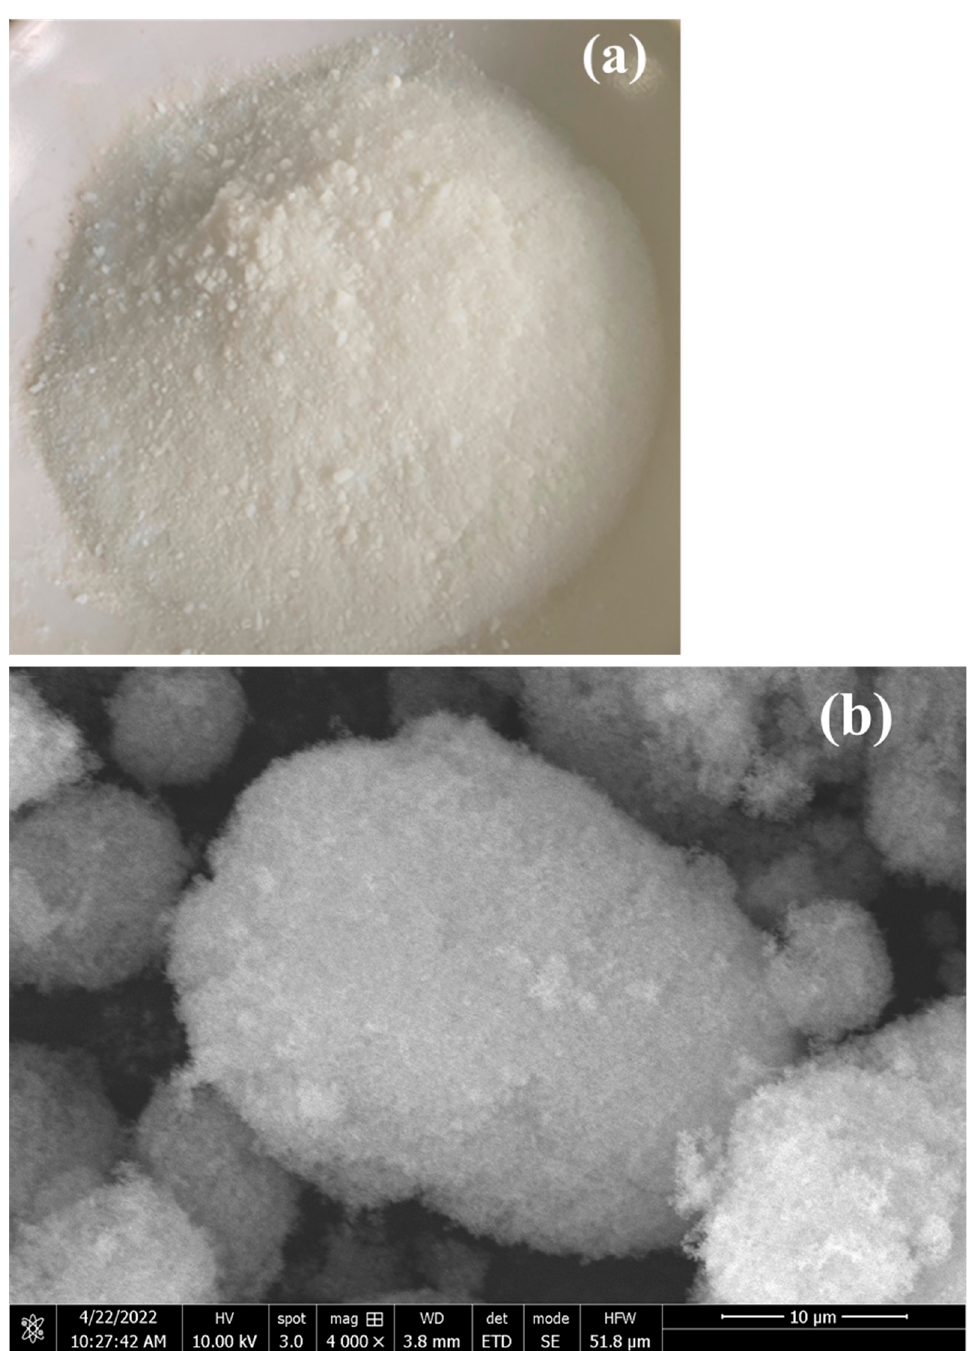
Figure 3. ( a ) Raw material of SiO 2 ; ( b ) SEM image of SiO 2 .